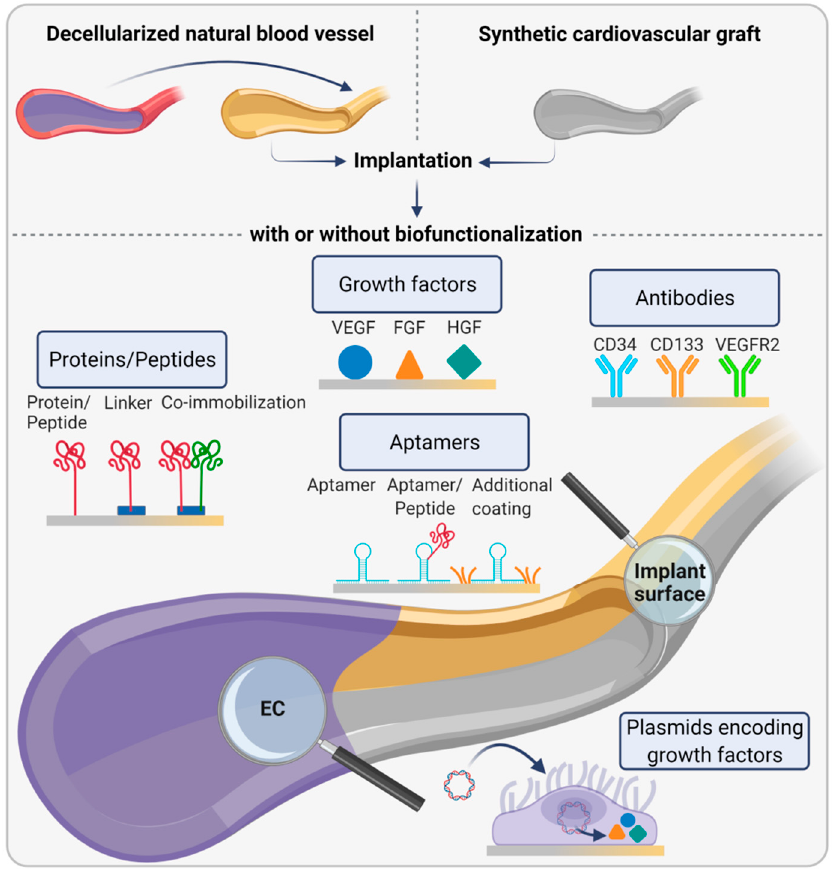
Figure 6. In vivo approaches for recruiting endothelial cells (EC) to implant surfaces. Human- or animal-derived decellularized natural blood vessels or synthetic cardiovascular grafts are used as replacements with or without further modification. Different strategies exist to biofunctionalize implant surfaces in order to promote endothelialization in vivo. The most frequently pursued approach to attract EC is immobilizing proteins or peptides, with or without linker molecules, to implant materials. Another possibility is to coat materials with growth factors such as vascular endothelial growth factor (VEGF), fibroblast growth factor (FGF), or hepatocyte growth factor (HGF) to promote EC adhesion. In a similar approach, plasmids encoding growth factors are attached to implant materials to induce increased local concentrations of these factors after cell transfection leading to enhanced endothelialization. Moreover, aptamers, either alone or in combination with aptamer-bound peptides or surface-bound molecules, are studied for their potential to promote EC adhesion. Functionalization of implant surfaces with antibodies is another approach to specifically capture endothelial progenitor cells and mature EC from the bloodstream.